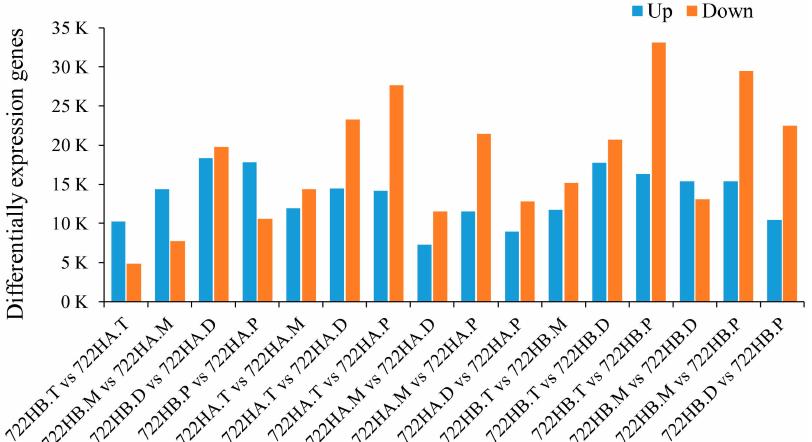
Figure 3. Di ff erentially expressed gene (DEG) statistics. The X axis represents the groups. The Y axis represents the numbers of DEGs. 722HA.T, 722HA.M, 722HA.D, and 722HA.P correspond to microspores of the tetrad, mononuclear, dinuclear, and mature pollen grains stages, respectively, in 722HA; 722HB.T, 722HB.M, 722HB.D, and 722HB.P correspond to microspores of the tetrad, mononuclear, dinuclear, and mature pollen grain stages, respectively, in 722HB.